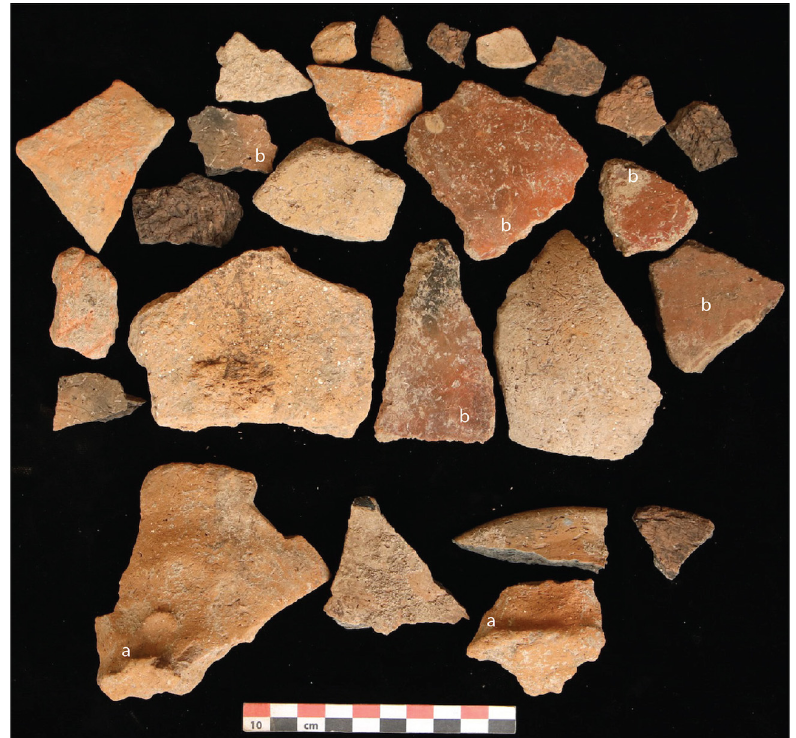
Figure 5: A selection of pottery sherds from the kiln fi ll. ( a ) Diagnostic sherds from a small conical bowl and ( b ) body sherds from a painted and polished pot. Prepared by Jean - Jacques